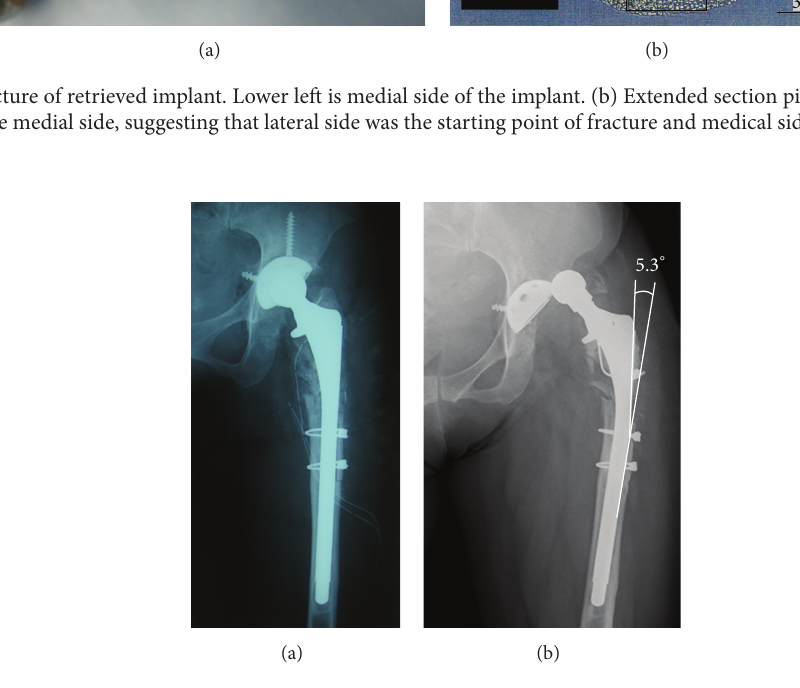
Figure 4: (a) The stem lateral bending was 0 ∘ immediately after revisional THA. (b) The stem bending was stronger than before, with the bending degree being 5.3 ∘ at final